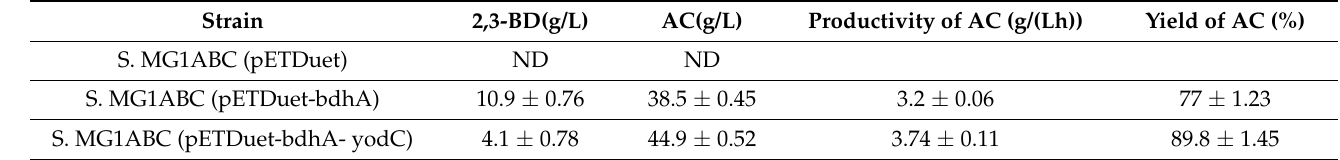
Table 4. The products of batch bioconversion with different cofactor regeneration systems.